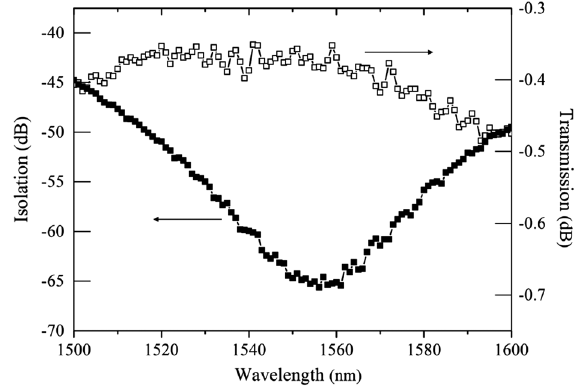
FIG. 7. Spectral characterization of a dual-stage optical isolator. The isolator shows less than 0.36 dB insertion loss in the forward direction (right axis, empty squares) and more than 65 dB isolation in the backward direction (left axis, filled squares) around the central wavelength of 1550